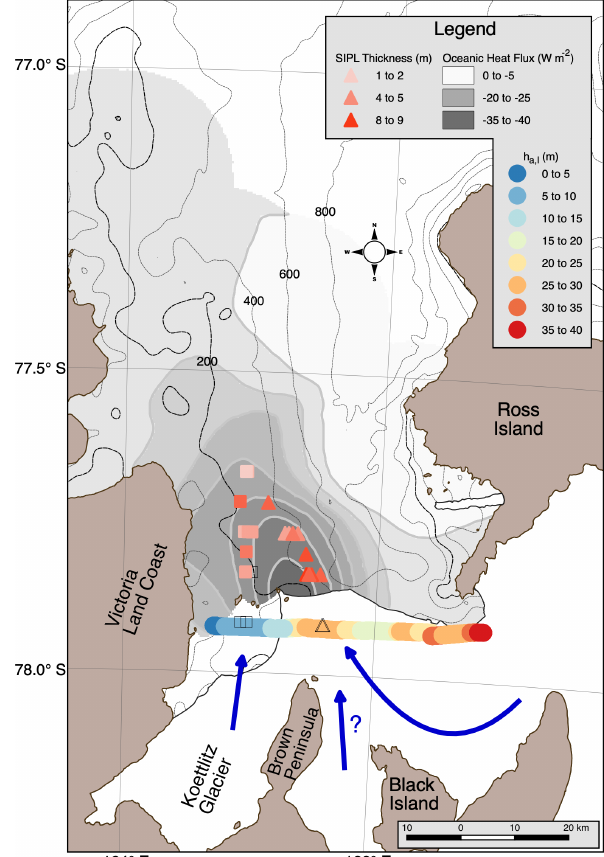
Figure 12. (a) SIPL thickness of peaks A and B (averaged over 0.1 ◦ of longitude) vs. distance from ice shelf front for all years 2009, 2011, 2013, 2016, and 2017 (see Fig. 11). (b) East–west cross- sectional area through the SIPL region (defined as greater than 1m thickness). Simultaneous SIPL volumes over a 675km 2 area in the central McMurdo Sound from Brett et al. (2020) are shown on the right (squares). Error bars assume a ± 0 . 5m data reduction model uncertainty in EM SIPL measurements (Sect.